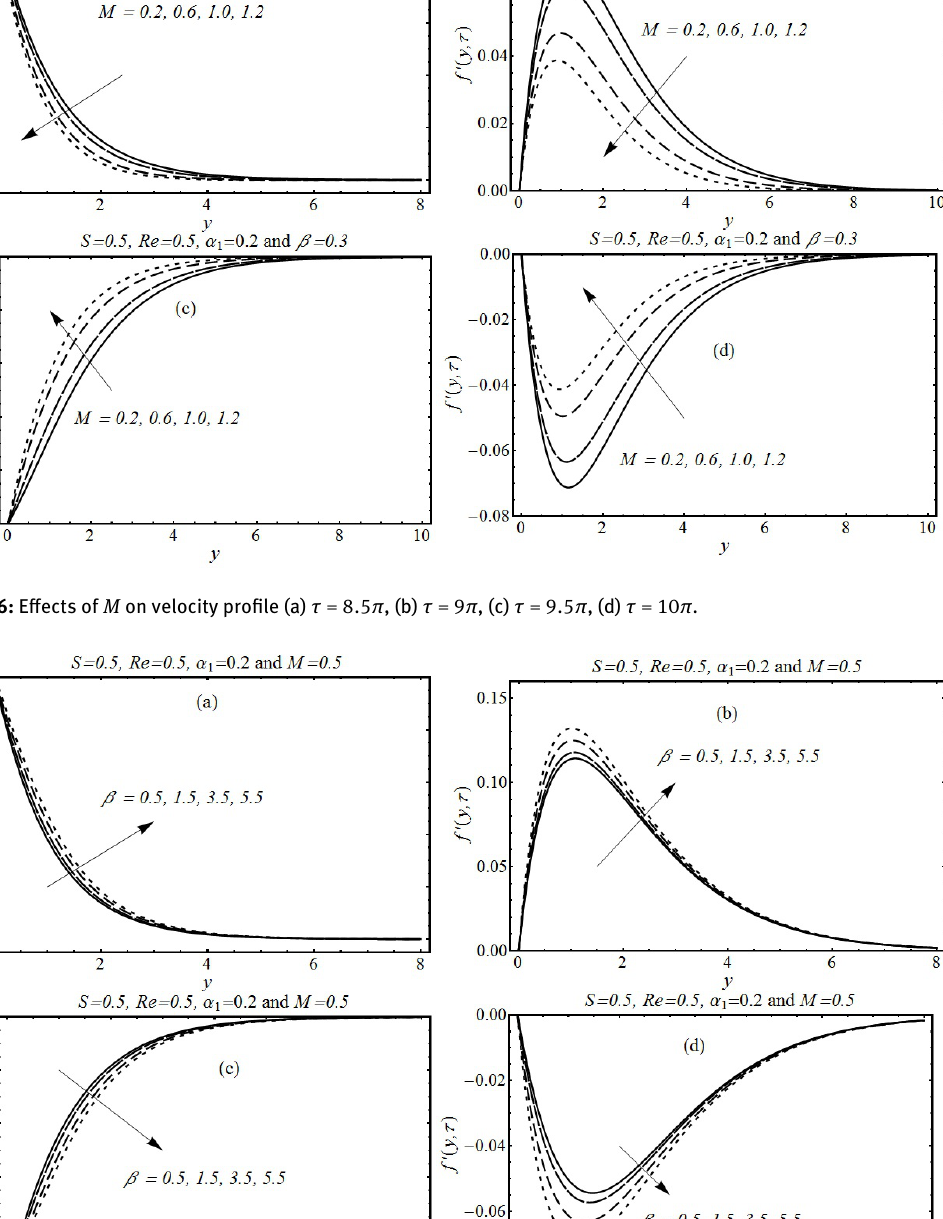
gradefluidparameter β atdifferenttimeinstantbykeeping other parameters constants. Fig. 7(a) shows that the mag- nitude of the velocity is an increasing function of β . Sim-